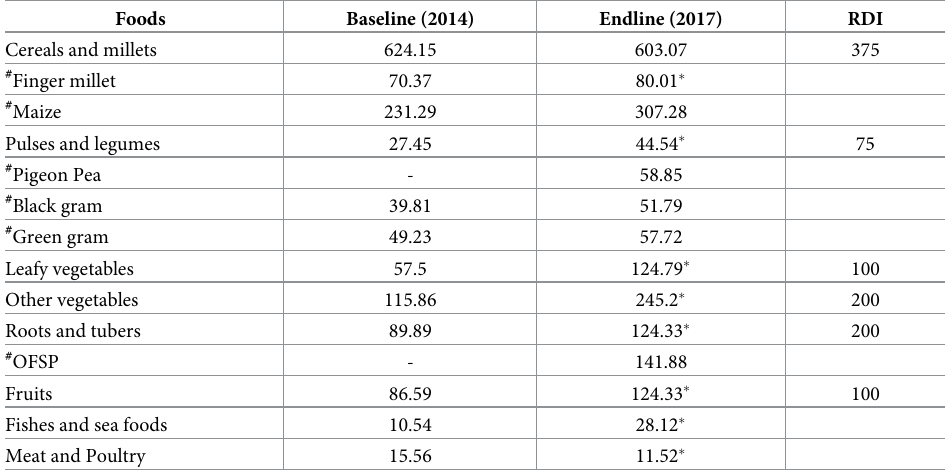
Table 4. Average intake (g/CU/day) of different food groups against recommended dietary intake (RDI) between Baseline (2014) and Endline (2017) in Koraput (N =